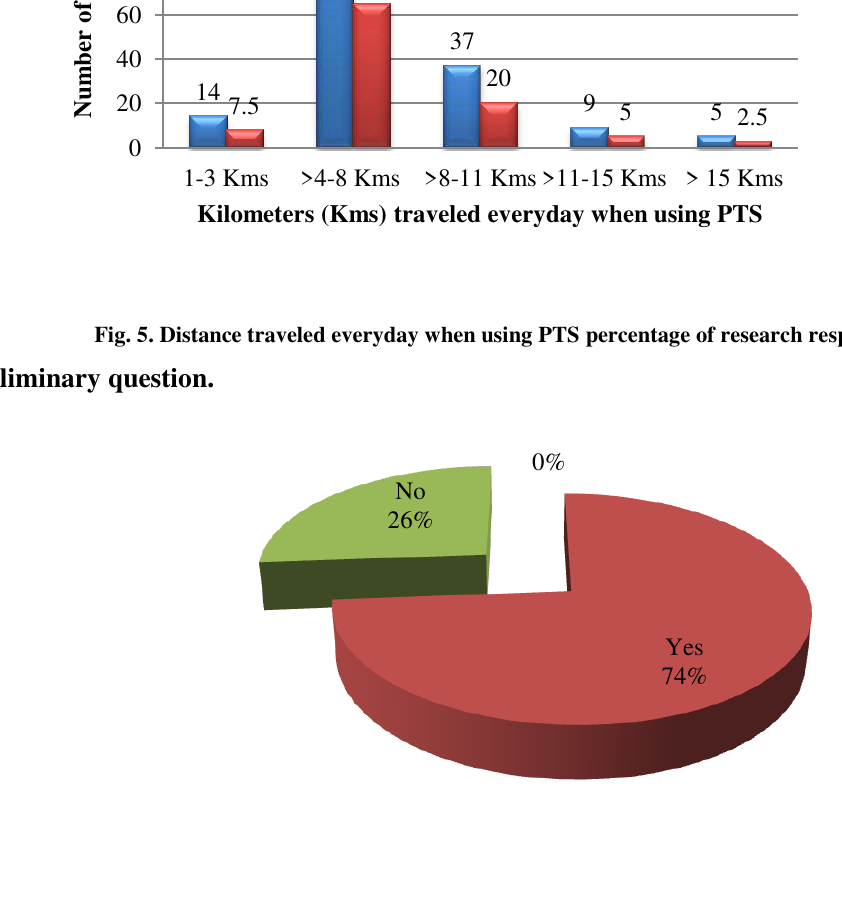
Fig. 6. Regular commuters using public transportation system (PTS) percentage of research